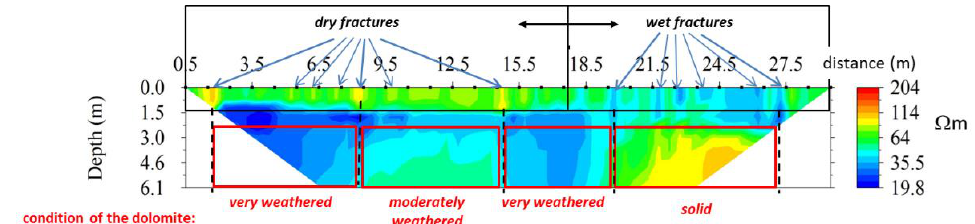
Figure 7. Fracture localization by electrical resistivity tomography (ERT) method (Stummer array, 30 electrodes, 1 m electrode spacing). Dotted lines are rock block boundaries; the condition of the dolomite is assumed on the basis of its resistivity (Section 3.1.2).